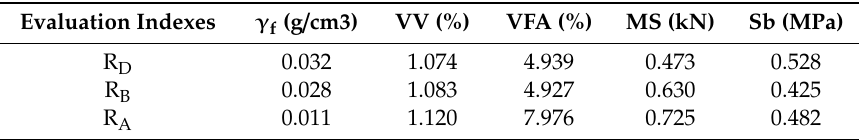
Figure 1. Relationship between mean value of each factor under different evaluation indexes: ( a ) γ f ; ( b ) VV; ( c ) VFA; ( d ) MS; ( e ) S b . Table 7. The results of range analysis for evaluation indexes.